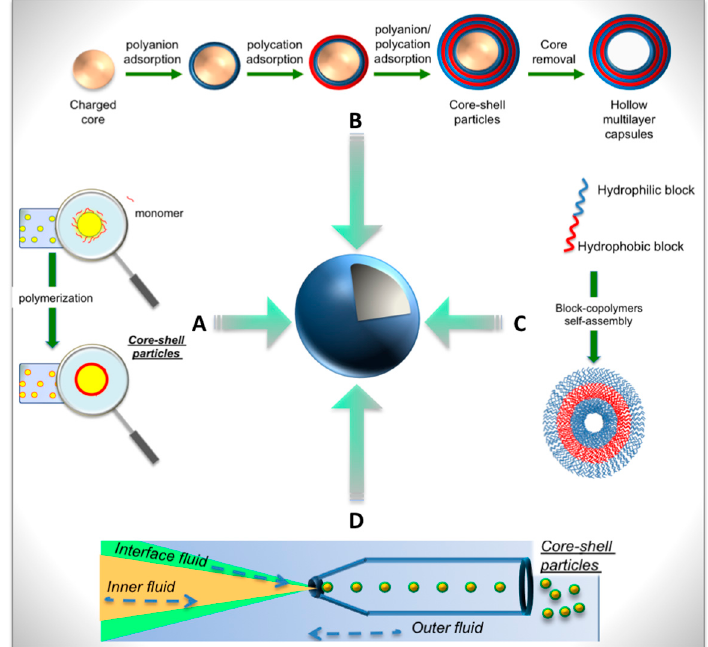
Figure 1. The representative illustration of polymer capsule main routes of fabrication; ( A ) emulsion polymerization; ( B ) layer-by-layer (LbL) assembly; ( C ) block copolymer self-assembly; ( D ) flow focusing method.